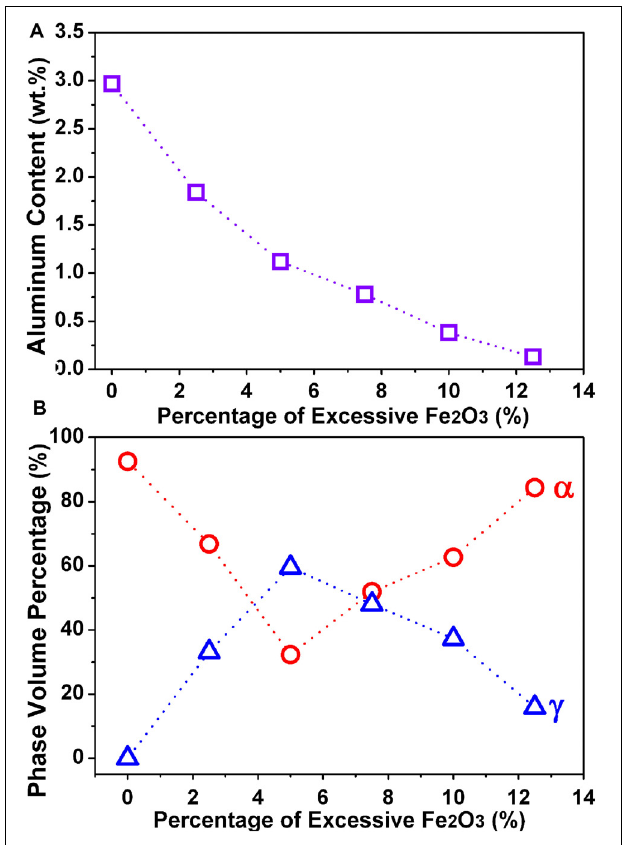
FIGURE 5 | Relationship between the excess percentage of Fe 2 O 3 and the Al content (A) and the volume fractions of α and γ phases (B) in 2205